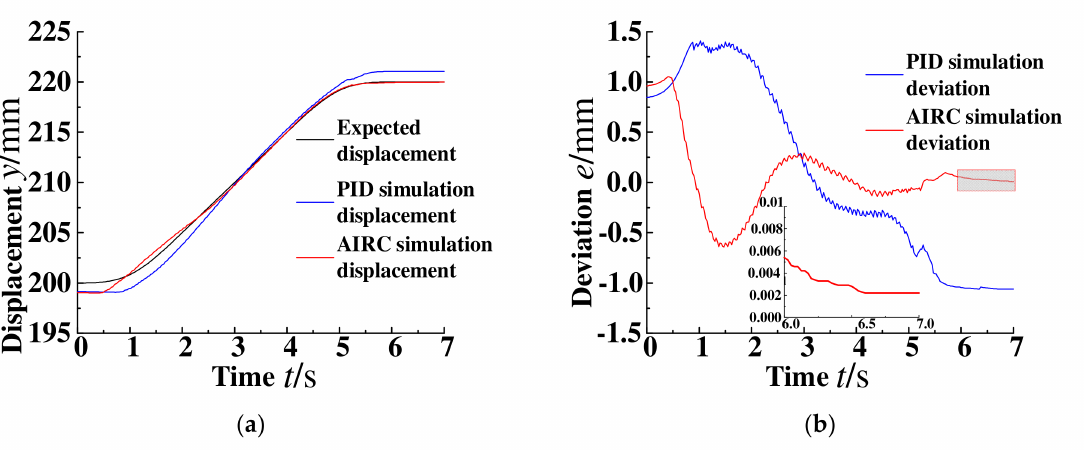
Figure 11. System displacement and deviation curve under working condition 1 (cid:13) . ( a ) System displacement curve. ( b ) System displacement deviation curve.